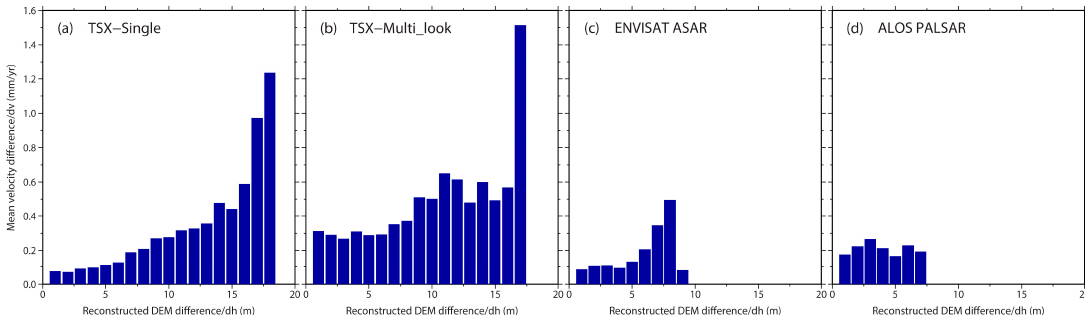
Figure 16. The relationship between absolute average mean deformation rate difference and reconstructed absolute DEM difference caused by external DEMs at the three platforms: ( a ) the statistical result between single-look geocoding with TanDEM-X DEM and single-look geocoding with SRTM-1arc DEM; ( b ) the statistical result between single-look geocoding with TanDEM-X DEM and multi-look geocoding with SRTM-1arc DEM; and ( c , d ) the statistical results between single-look geocoding with TanDEM-X DEM and single-look geocoding with SRTM-1arc DEM for C and L band, respectively.